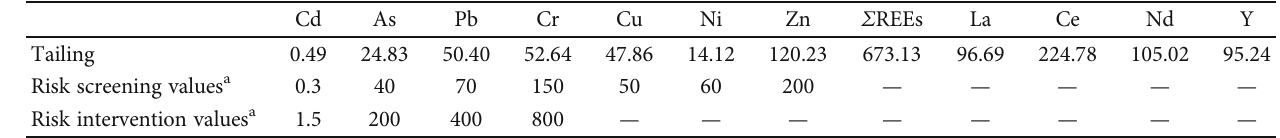
Table 2: The heavy metal content of the soil substrate in rare earth mine tailings (mg/kg).